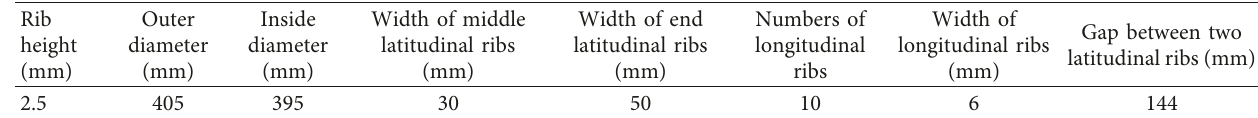
Table 7: Parameters of the sample with 2.5mm height ribs.